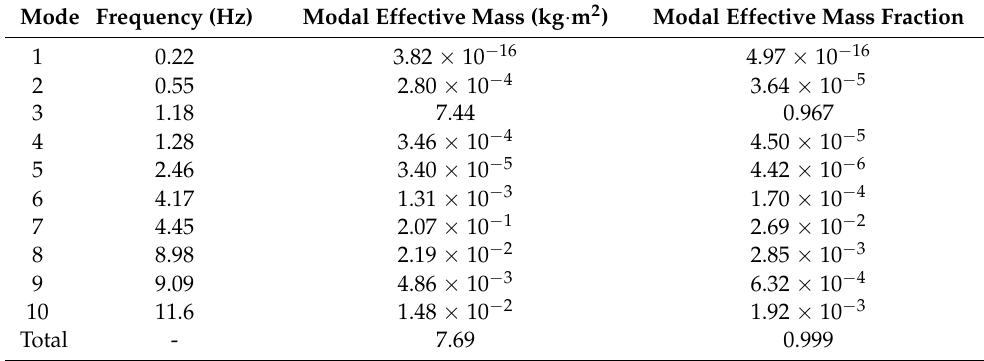
Table 1. Modal effective mass and proportion of the solar array.